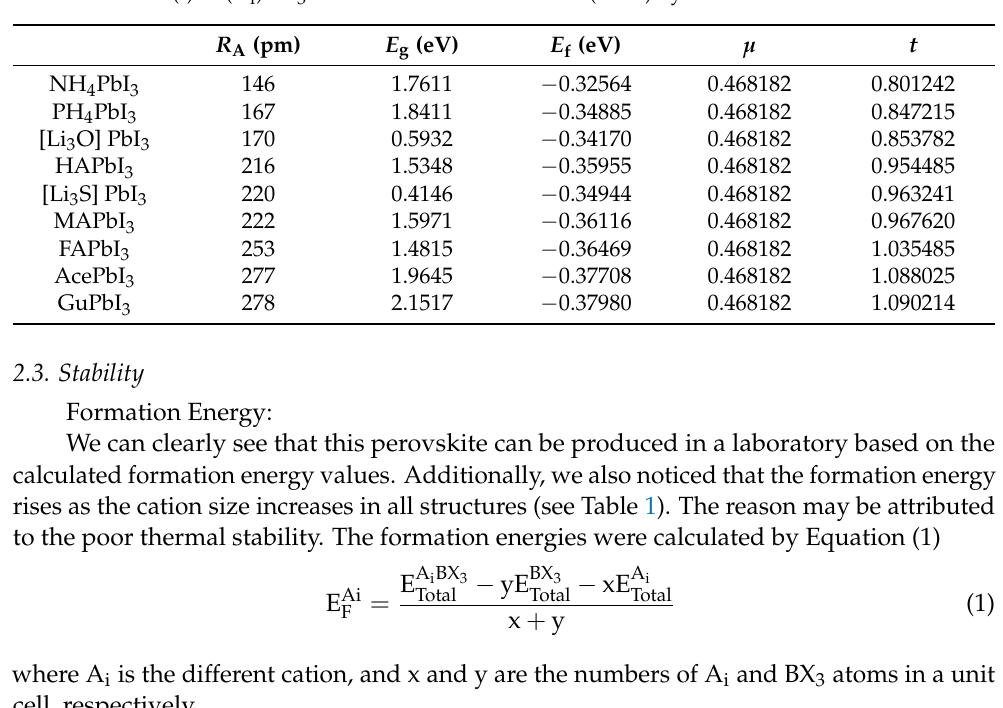
Table 2. Estimated radii ( R A ), band gap ( E g ), formation energy ( E f ), polyhedral factor ( µ ) and tolerance factor ( t ) of (A i )PbI 3 Perovskites with GGA-PBE (vdW) by theoretical